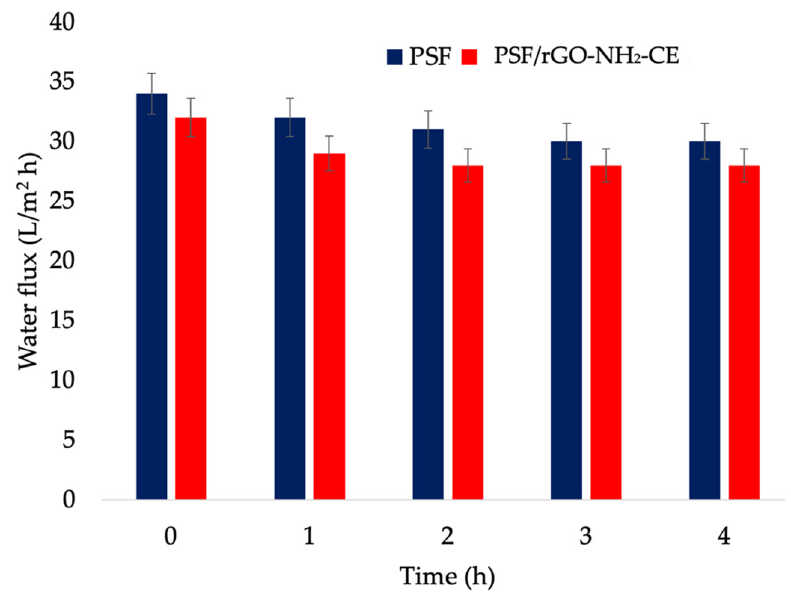
Figure 10. Water fluxes through polysulfone and polysulfone composite membranes after 4 h of of recirculation.